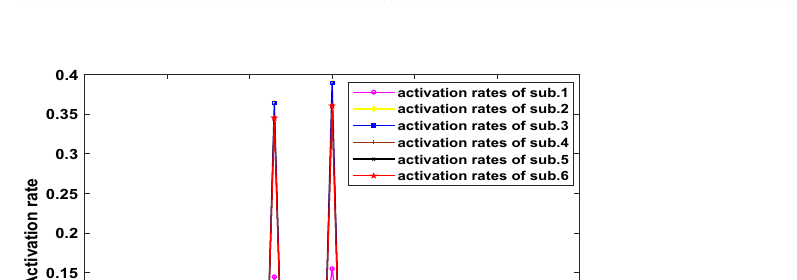
Figure 18. The activation rates of 56 rules generated by all samples.